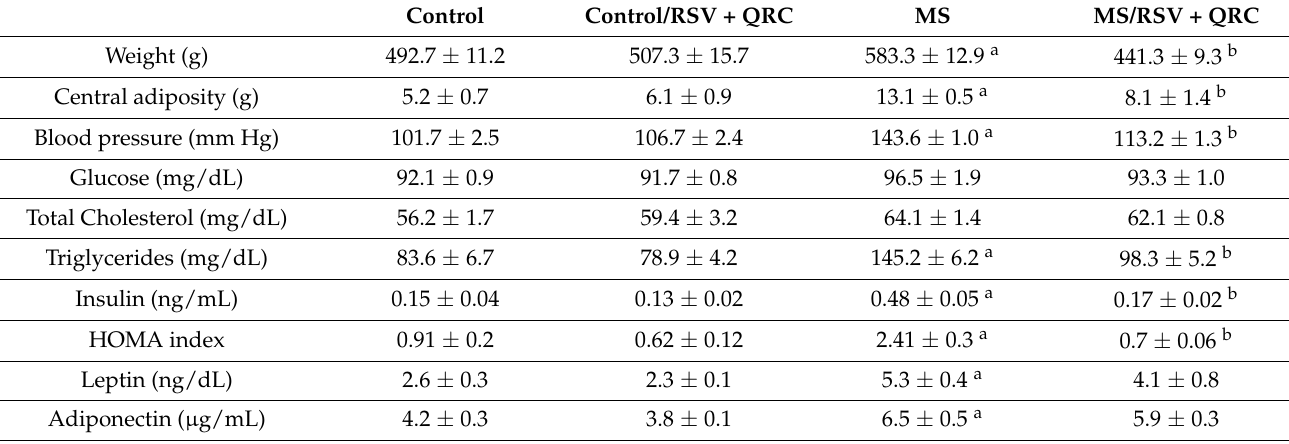
Table 1. The effects of the administration of RSV + QRC on body characteristics and biochemical parameters in Control and Metabolic syndrome (MS)